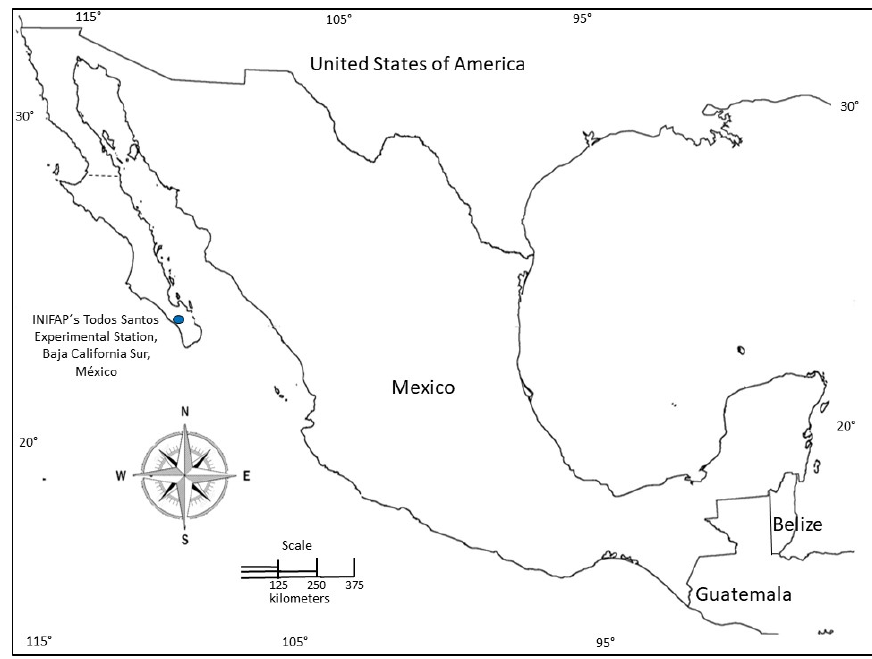
Figure 1. Todos Santos Experimental Station location (blue dot). Table 1. Meteorological parameters for the growing seasons (monthly average for every variable) in the Todos Santos Experimental Station location, Baja California Sur, Mexico.